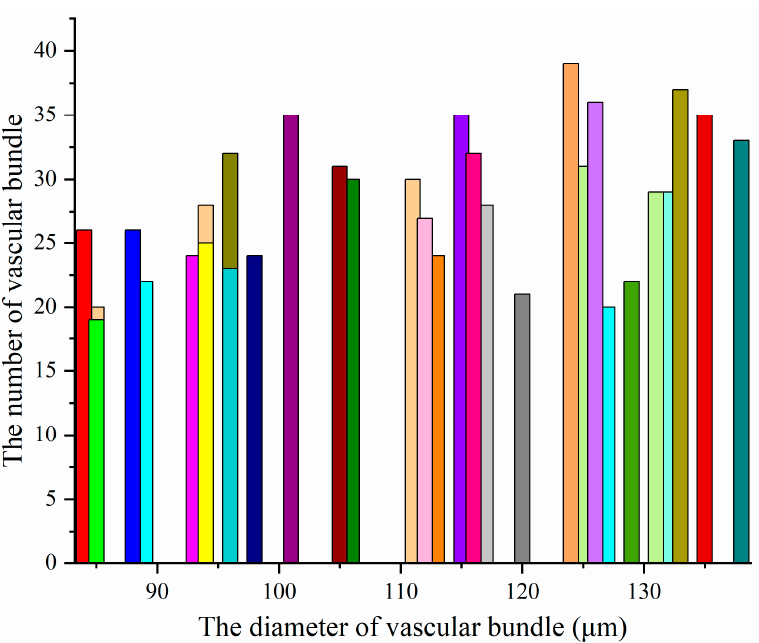
Figure 15. The relationship between the diameter of the vascular bundle and the number.